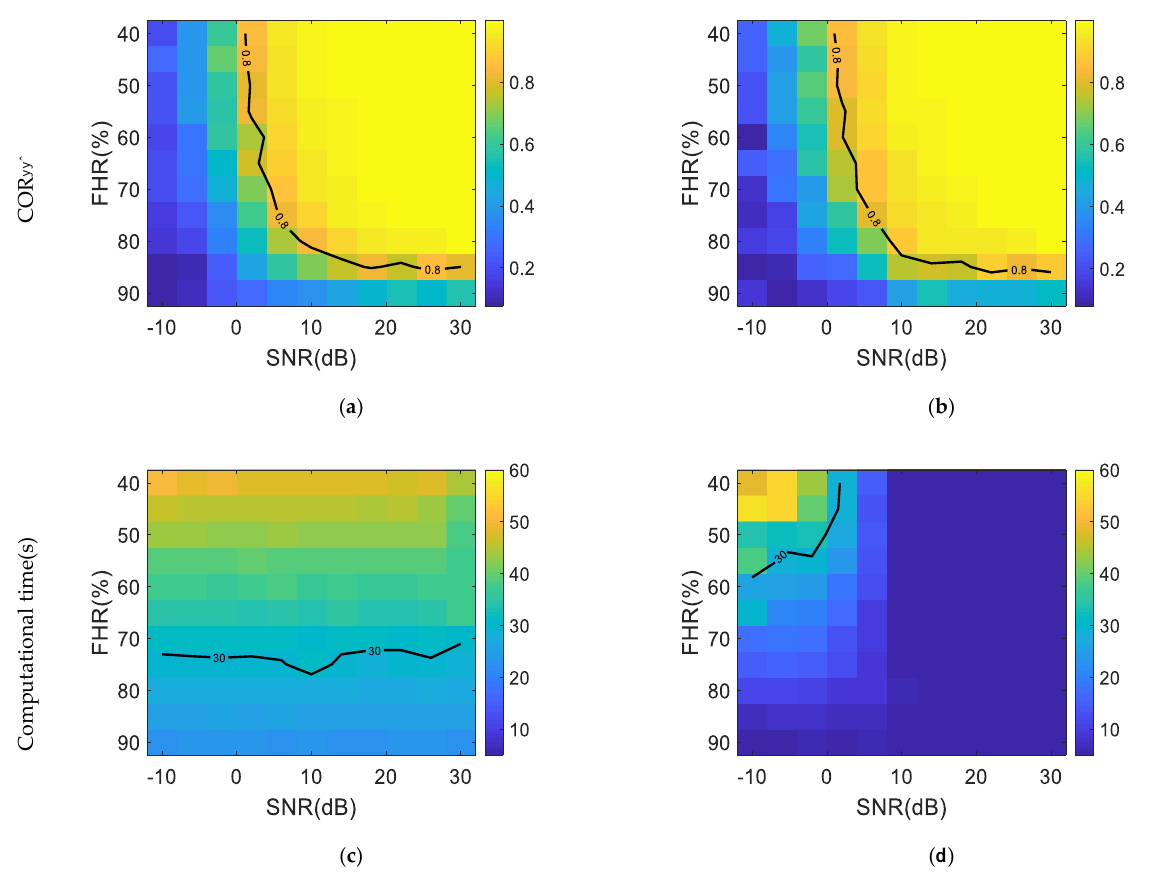
Figure 10. The averages of the ˆ COR yy and computational time(s): ( a ) averaged ˆ COR yy of the GTD – SPICE method, ( b ) averaged ˆ COR yy of the DE – GTD – SPICE method, ( c ) computational time of the GTD – SPICE method, and ( d ) computational time of the DE – GTD – SPICE method.